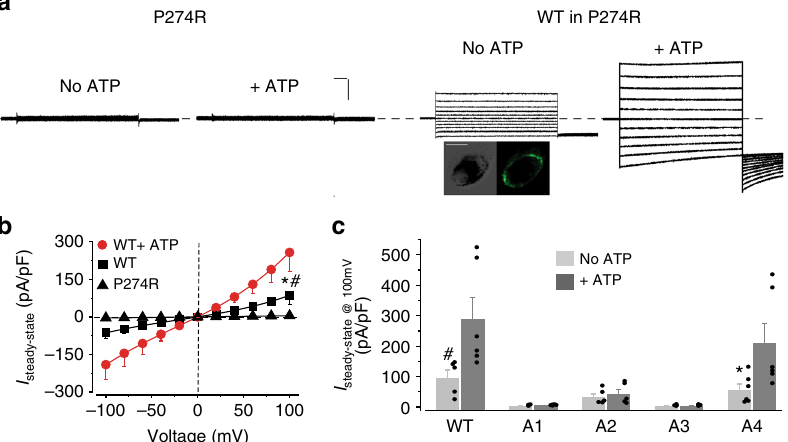
Fig. 5 The role of candidate motifs on hBest1 in ATP-dependent activation. a Left, representative current traces recorded from hBest1 P274R iPSC-RPE. Right, representative current traces in hBest1 P274R iPSC-RPE complemented with WT hBest1-GFP (Scale bar, 1.5 nA, 100 ms). Insert, confocal images showing expression of WT hBest1-GFP in rescued P274R iPSC-RPE (Scale bar, 10 μ m). b Population steady-state current – voltage relationships in P274R iPSC-RPE, and in P274R iPSC-RPE complemented with WT hBest1-GFP in the absence or presence of 2 mM ATP, n = 5 – 6 for each point. *# P < 0.05 compared to uninfected cells and complemented cells in presence of ATP, respectively, using two-tailed unpaired Student t test. c Bar chart showing the steady-state current amplitudes of P274R iPSC-RPE complemented with WT or mutant hBest1 channels, n = 5 – 6 for each bar. # * P < 0.05 compared to currents from the same set of cells in the presence of 2 mM ATP, respectively, using two-tailed unpaired Student t test. All error bars in this fi gure represent s.e.m.